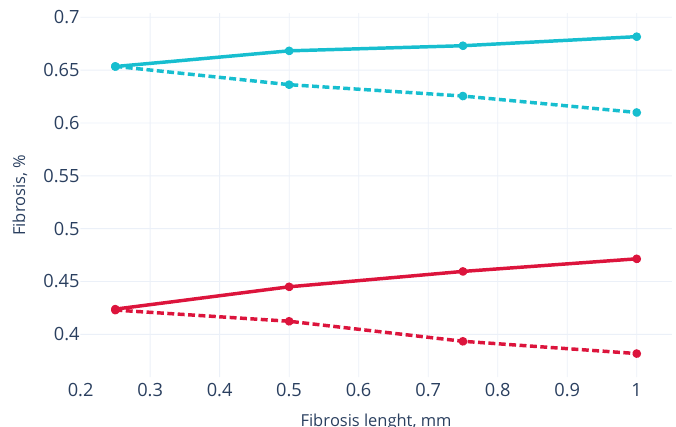
Figure 7. A threshold fibrosis percentage (FP 95 ) for 95% of models with conduction block depending on the fibrosis obstacle length for longitudinal (solid lines) and transversal (dotted lines) wavefront direction in the monolayer (lower red lines) and multilayer (upper blue lines)